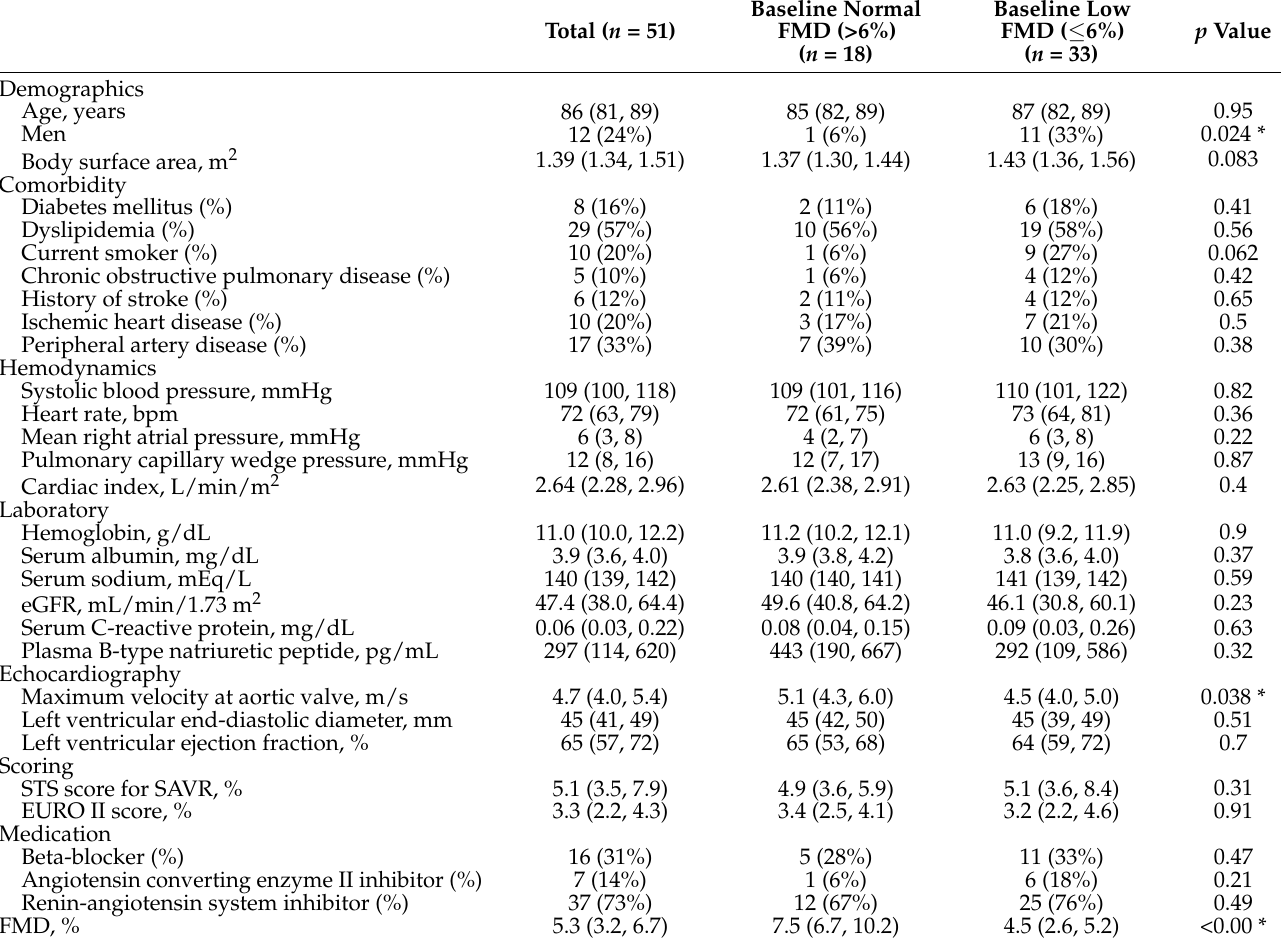
Table 1. Baseline